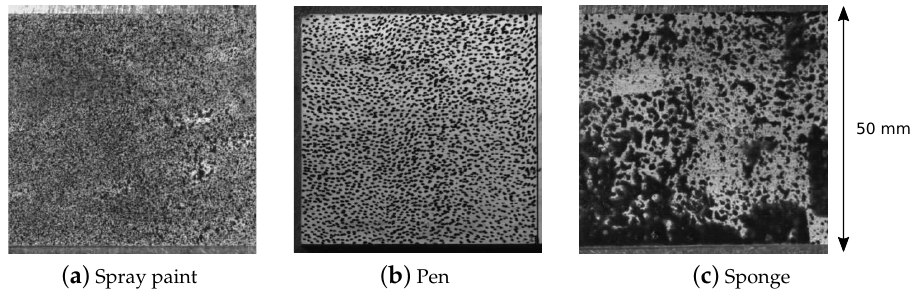
Figure 2. Experimental speckles on aluminum